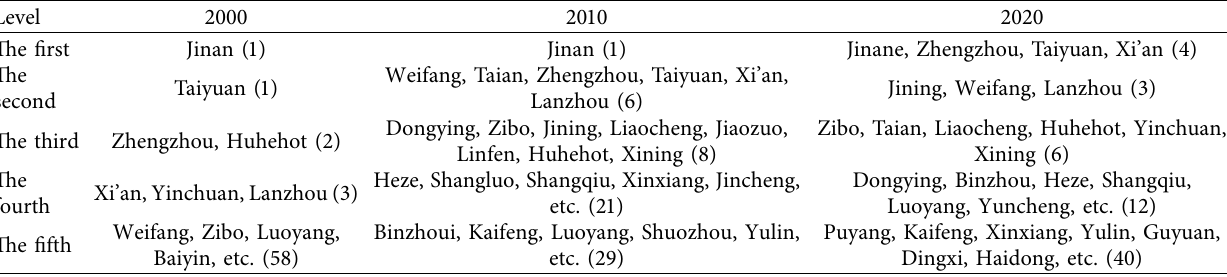
Table 1: Hierarchical distribution of urban nodes based on producer